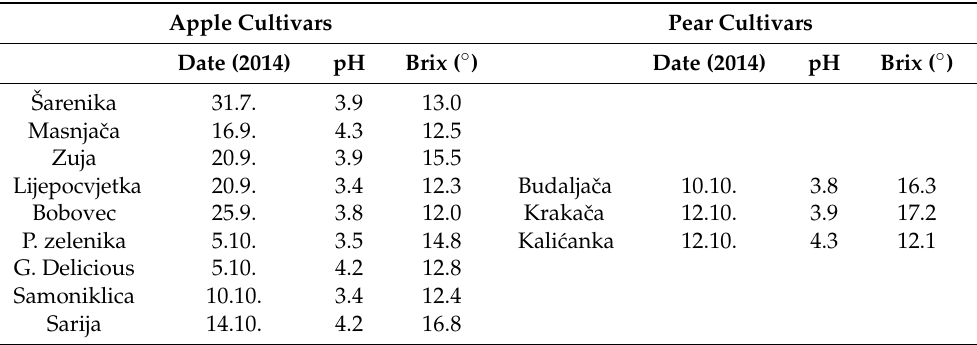
Table 1. Date of fruits delivery to the pilot plant and quality parameters of mashes obtained from old apple and pear